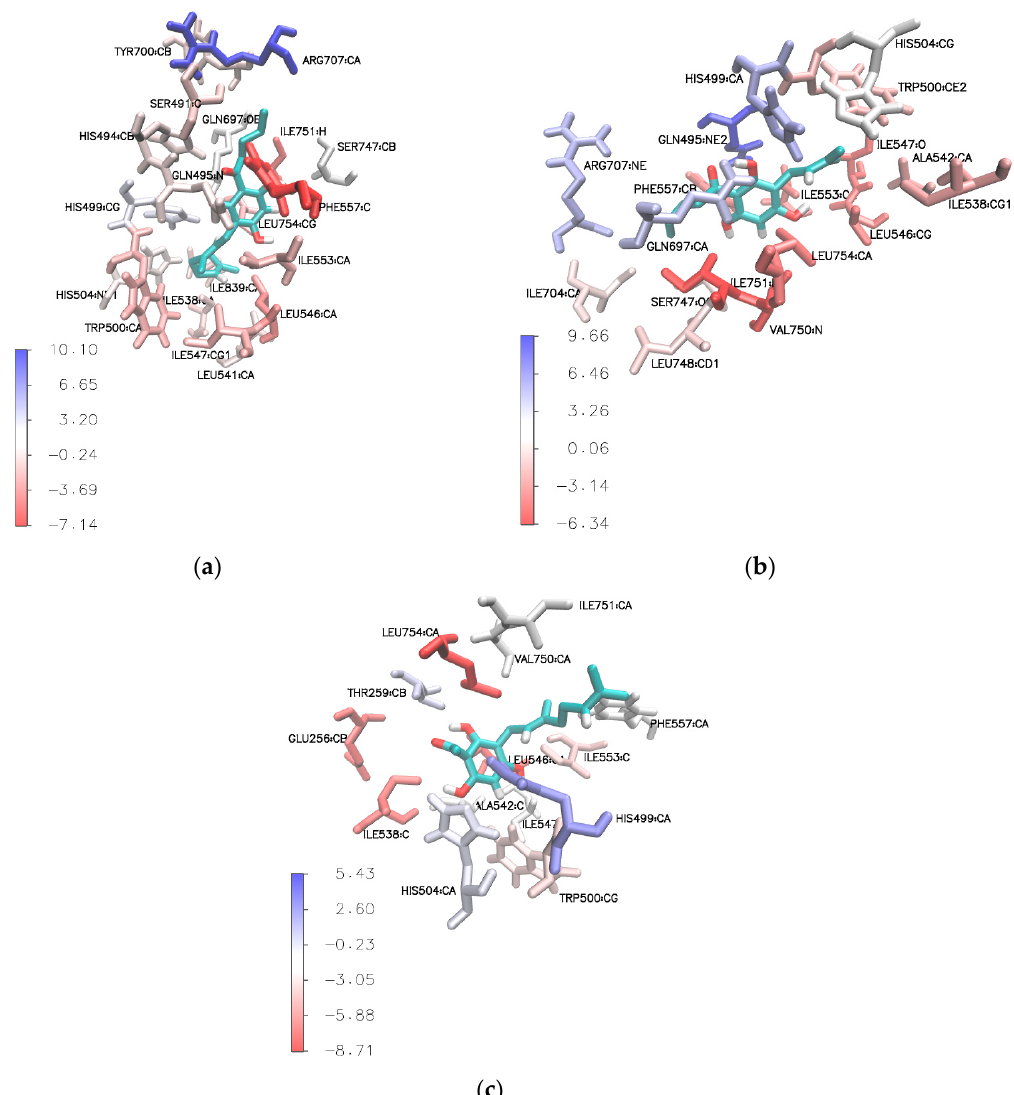
Figure 8. Stereo view of binding sites of ( a ) compound 3e , ( b ) compound 4e , and ( c ) compound 3a (tHGA) after simulation. Residues that favor binding interactions are colored in red; residues that are not favorable for binding interactions are shown in blue.